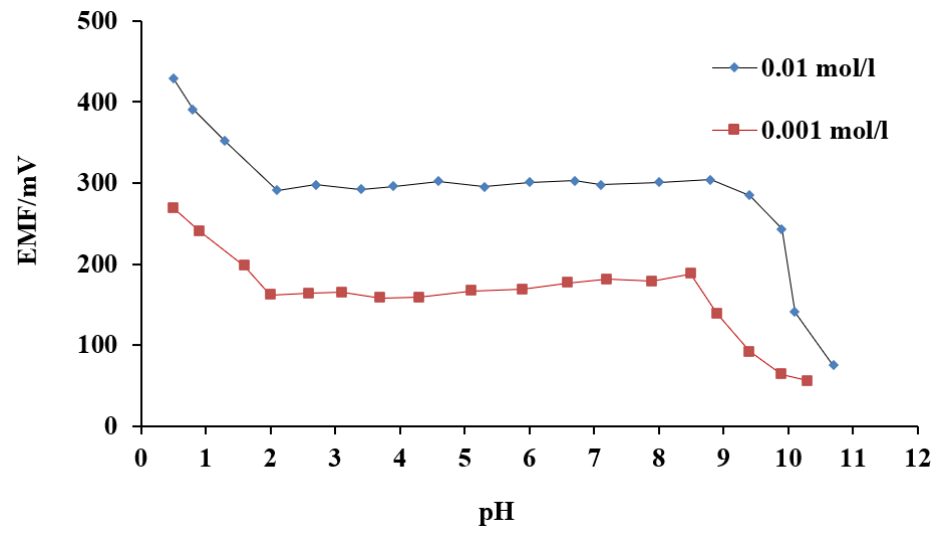
Figure 7. Role of test solution’s pH on the potential response of Hg 2+ –SE at different concentrations: (blue) 1.0 × 10 –2 and (red) 1.0 × 10 –3 molL –1 . (blue) 1.0 × 10 –2 and (red) 1.0 × 10 –3 molL –1 .